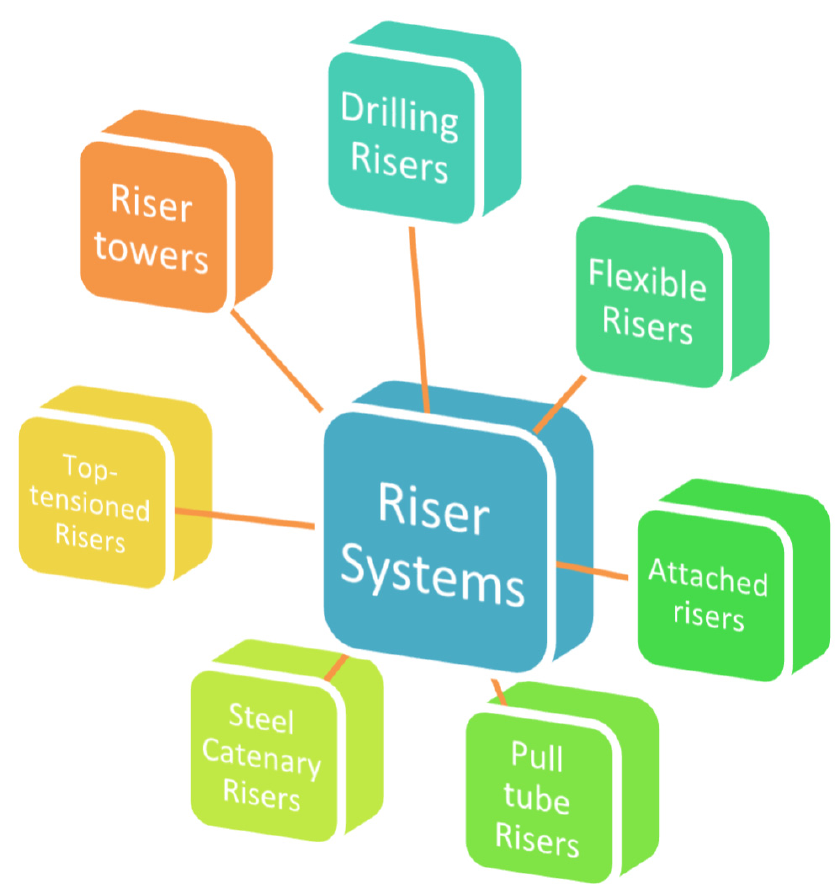
Figure 2. Different types of marine riser systems are considered for benchmarking composite risers.